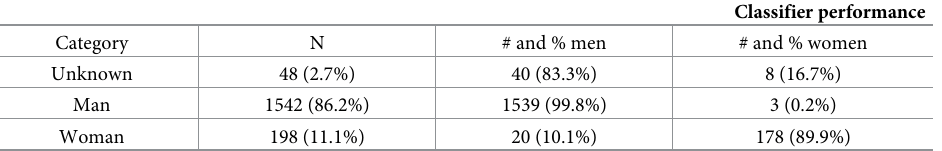
Table here. The publisher apologizes for the error. S3 Table. Photo validation of automated gender estimates. For each human-labeled category (rows), right columns indicate classification provided by genderize.io. The data and code needed to generate this table are available on Zenodo (DOI: